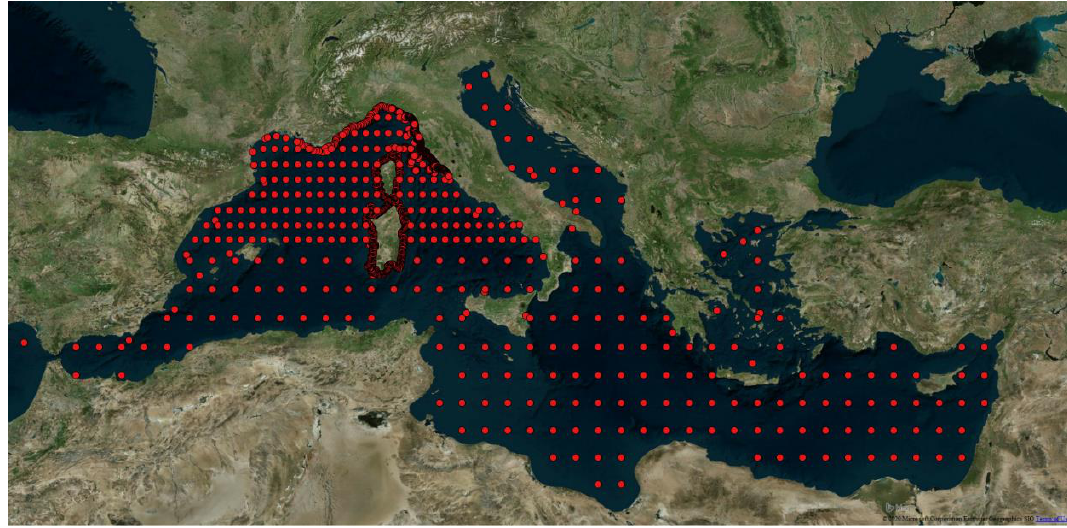
Figure 4. Point output of the wave hindcast.